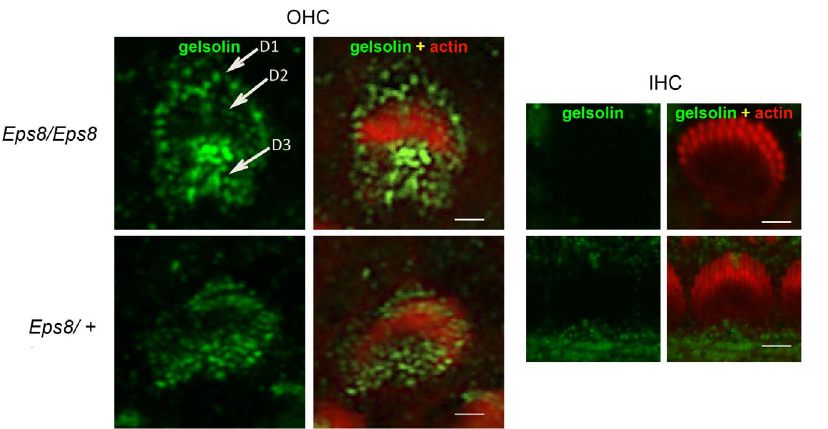
Figure 4. Gelsolin localization in cochlear hair cells of Eps8 knockout mice ( Eps8 tm1Ppdf /Eps8 tm1Ppdf ). Cochlear whole mounts from P8 mice were stained with antibody to gelsolin (green) and phalloidin (red) to detect actin. Right hand panels for OHC and IHC cells show merge of gelsolin and actin. Note the absence of IHC labeling. Gelsolin localizes to stereocilia of OHCs (domain D2) and is also detected outside of the stereocilia bundle in strial (D1) and neural (D3) domains of the apical hair cell surface. Gelsolin localization was not affected in the Eps8 knockout mice. Similar results were seen at P6 (data not shown). Scale bars: 10 m m.